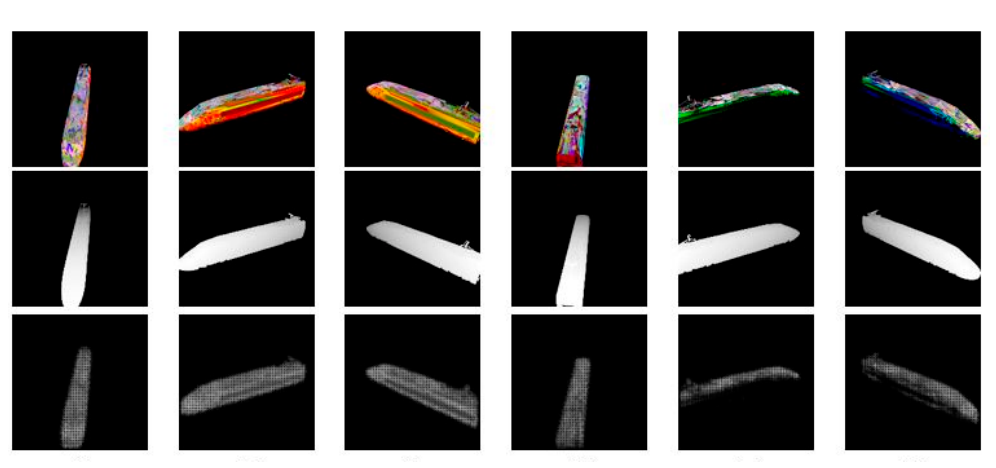
Figure 4. The results using the same train model. The top line shows the test images, the middle line shows the ground truth of each image, and the bottom line shows the depth our network predicts.